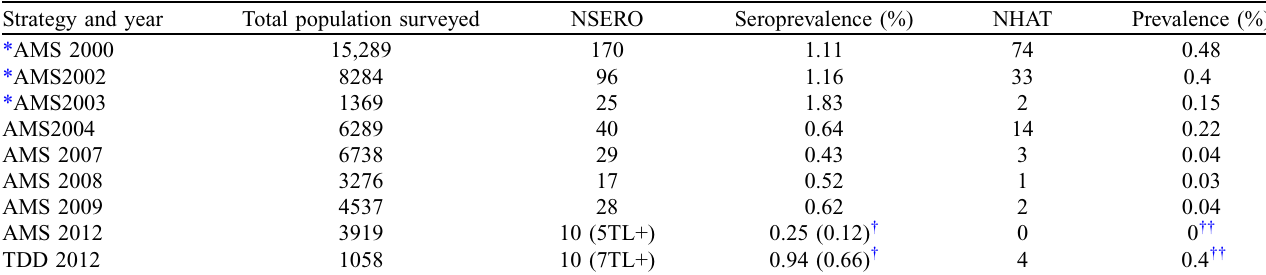
Table 1. Results of medical surveys in the Bonon focus from 2000 to